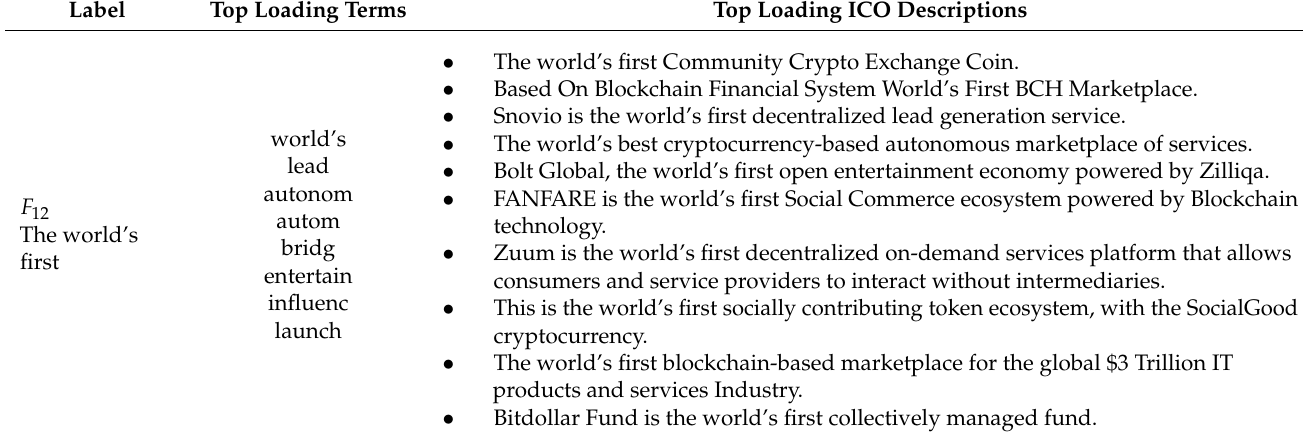
Table A12. The World First.